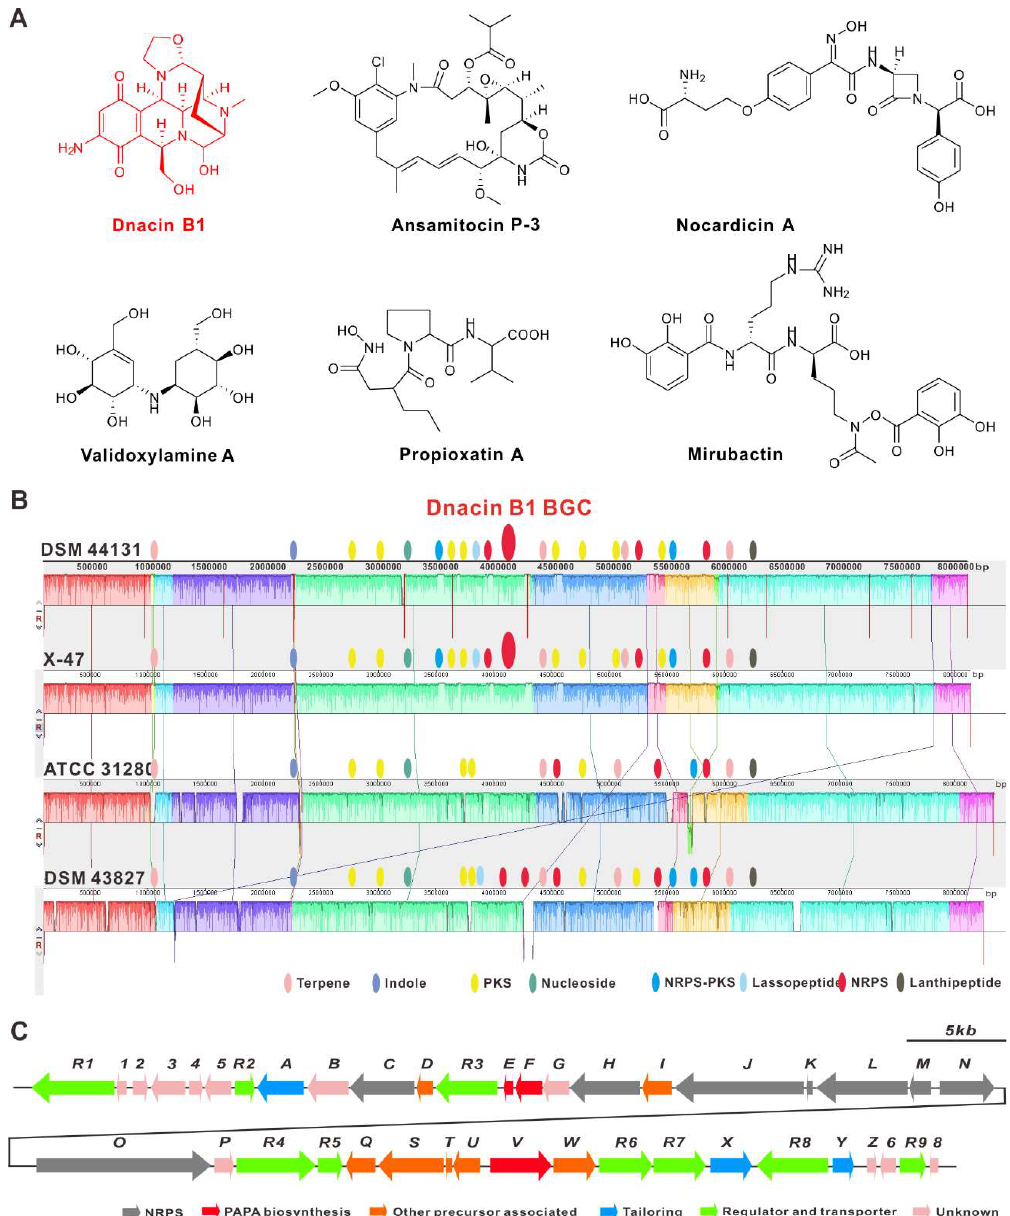
Figure 1. The diversified biosynthetic gene clusters located in the chromosome of Actinosynnema strains (DSM 44131 T , X47, ATCC 31280 and DSM 43827 T ). ( A ) The biological natural products discovered from the genus Actinosynnema . ( B ) Comparative genome sequence alignment among the Actinosynnema strains performed by MAUVE, indicating the variations in secondary metabolite-encoded biosynthetic gene clusters (BGCs) and discovering the BGC of dnacin B1 in the genome of strain DSM 44131 T and strain X47. ( C ) Genetic organization of dnacin B1 BGC.